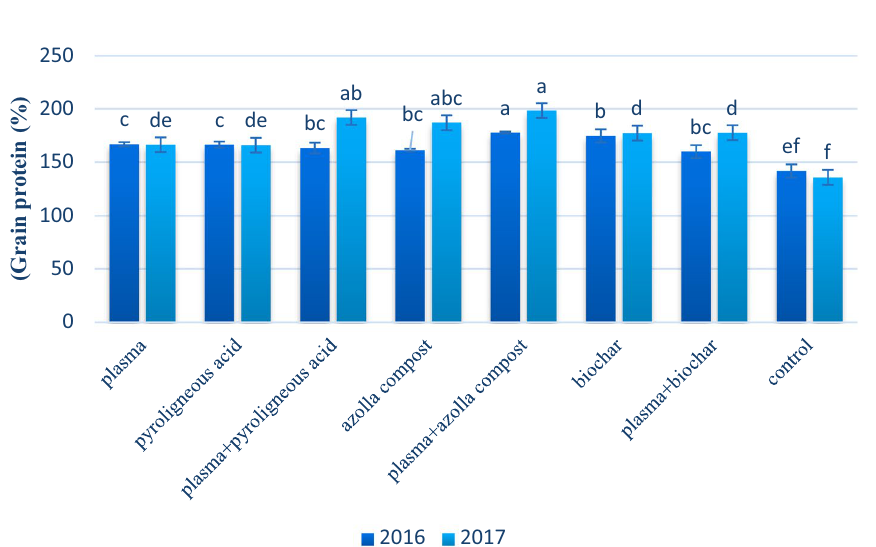
Figure 5. Mean comparison of effect of application of plasma, pyroligneous acid, azolla compost and biochar on grain protein of wheat.